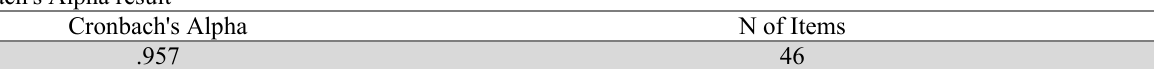
Cronbach's Alpha result